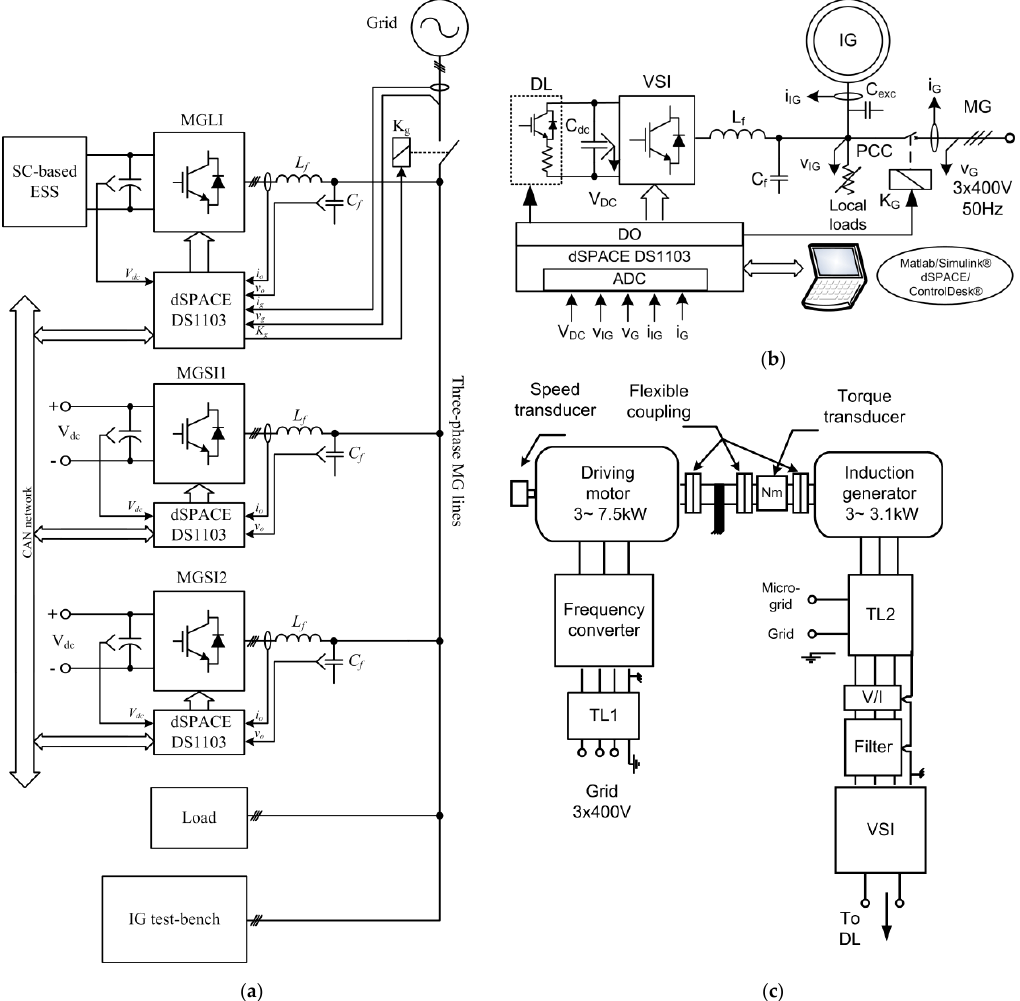
Figure 6. Experimental test-bench: ( a ) MG diagram with the integrated IG; ( b ) IG system electrical part, ( c ) IG system electro-mechanical part.